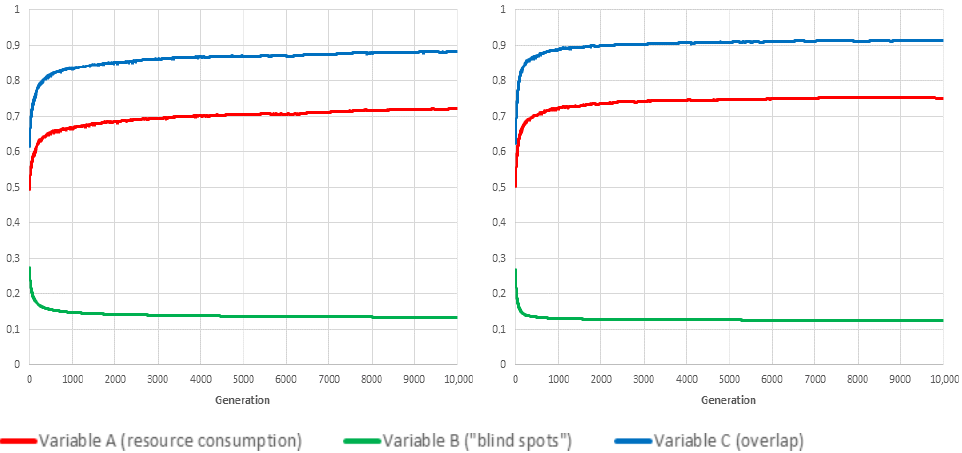
Figure 4. Benchmarking tests: β = 1, i.e., the value of F is only based on blind spots. Both variations ( left : mutation only; right : with sexual reproduction) perform comparable, the value of B may never drop entirely to zero due to unavoidable blind spots caused by the camera placement.